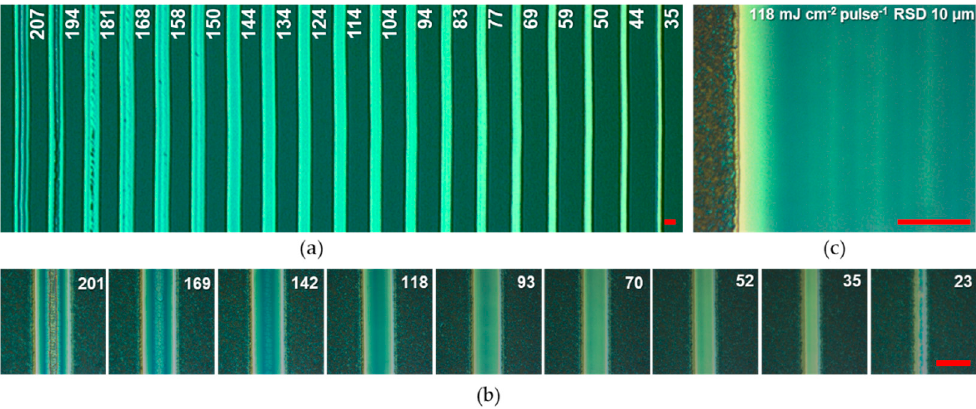
Figure 2. ( a ) Optical microscope image of a P2 power scan with a 355 UV ns laser over a sample made of glass/ITO/NiO x /perovskite/PCBM/BCP. The numbers indicate the fluence per pulse in mJ cm − 2 . Given the scribing speed of 195 mm s − 1 and a pulse frequency of 80 kHz, 12 pulses overlap in each point; ( b ) Microscope image of P2 scribes at different fluence per pulse; ( c ) The image of the P2 ablation used for modules, in which a series of P2 scribes are done parallel to each other with a distance (RSD) of 10 μ m. The red scale bars indicate 30 μ m.